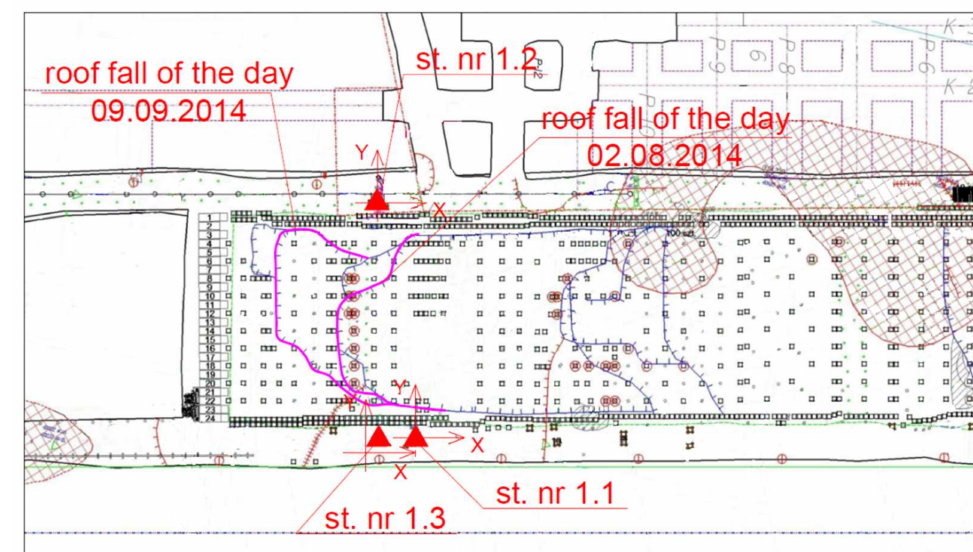
Figure 10. Location of measurement sensors against the mining situation in the A-1/5